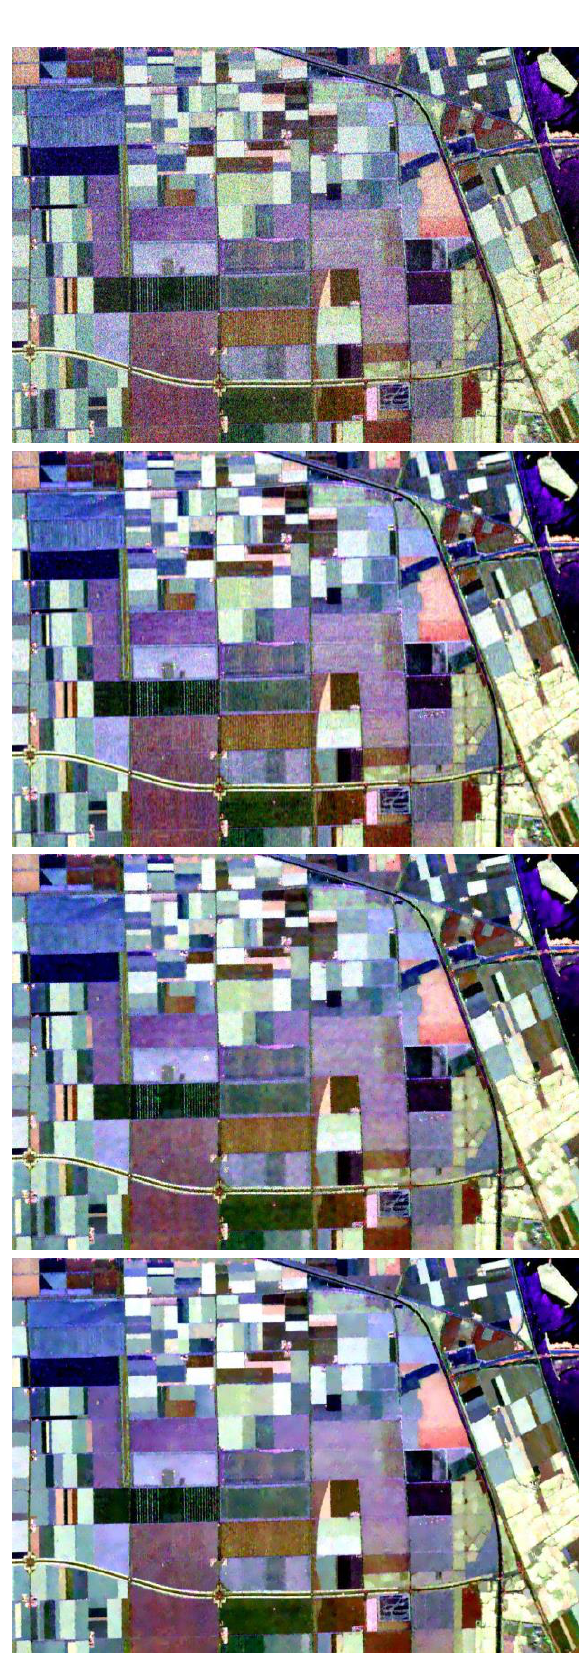
Figure 2. Pauli RGB images. From top to down, the speckled data, the POSSC de-speckled data, the PNGF de-speckled data, and the ANLM de-speckled data, respectively.